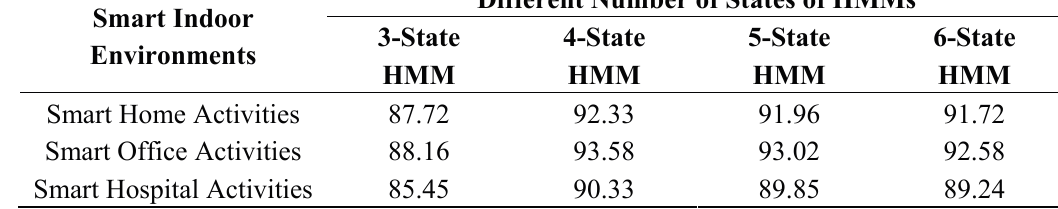
Table 1. Comparison of recognition results using hidden numbers of states of HMMs ranging from 3 to 6 for all smart indoor activity environments, under the same setting as described in Section